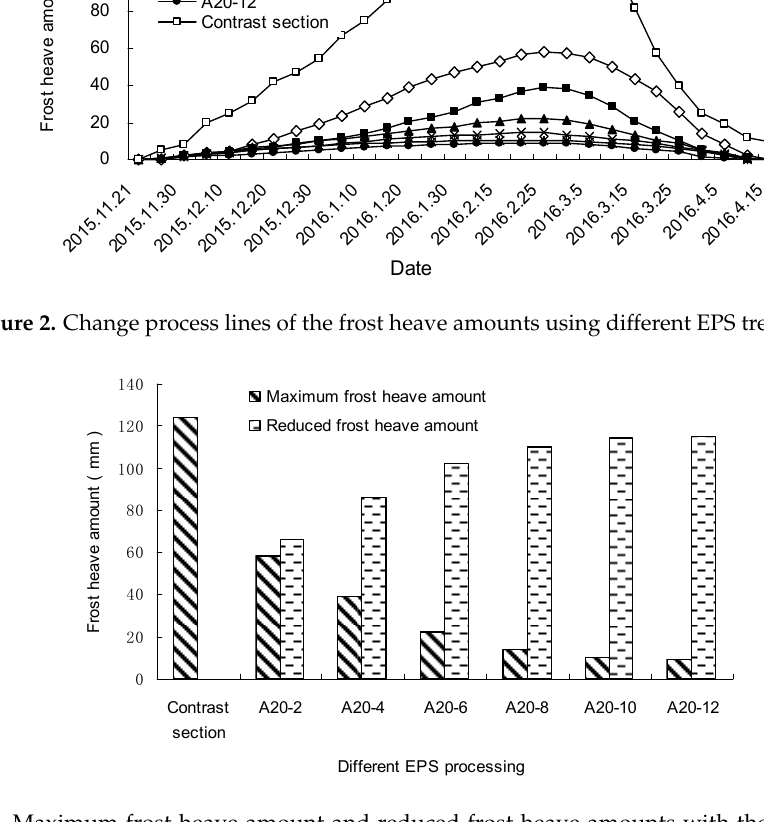
Figure 3. Maximum frost heave amount and reduced frost heave amounts with the different EPS processing procedures. Table 3. Eigenvalue and reduction rates of the frost heave amounts of EPS insulation boards with different thicknesses.